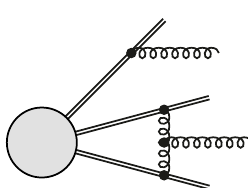
Figure 1 . Double soft-gluon emission dia- gram involving four Wilson lines. The loop integral is scaleless and vanishes.